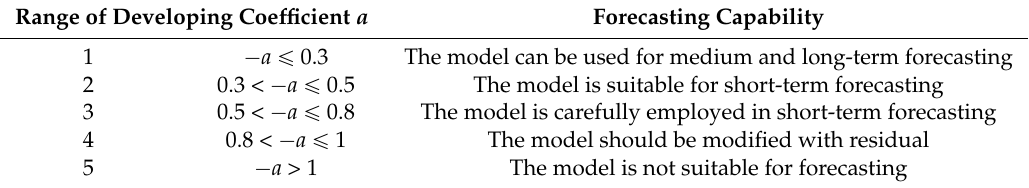
Table 1. Forecasting capability of the grey